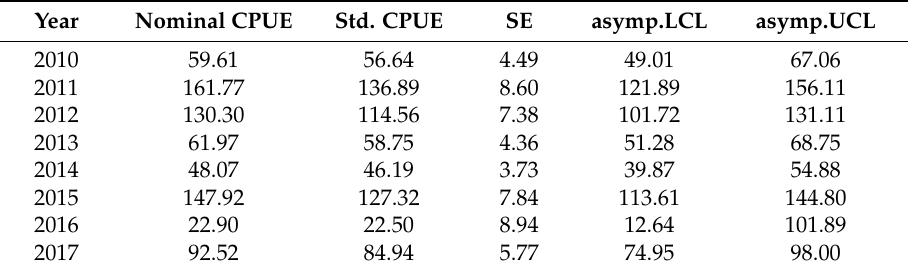
Figure 5. Scaled standardized CPUE series for skipjack from coastal drifting gillnet fishery using a gamma model, between 2010 and 2017. The solid lines refer to the standardized index (Std. CPUE) with the 95% confidence intervals (grey polygon), and the black dots represent the nominal CPUE series. Both series are scaled by their means. Table 3. Summary of the nominal CPUE, standardized index (Std. CPUE), standard error (SE), asymptotic lower confidence interval (asymp.LCL), and asymptotic upper confidence interval (asymp.UCL) for skipjack from coastal drifting gillnet fishery.